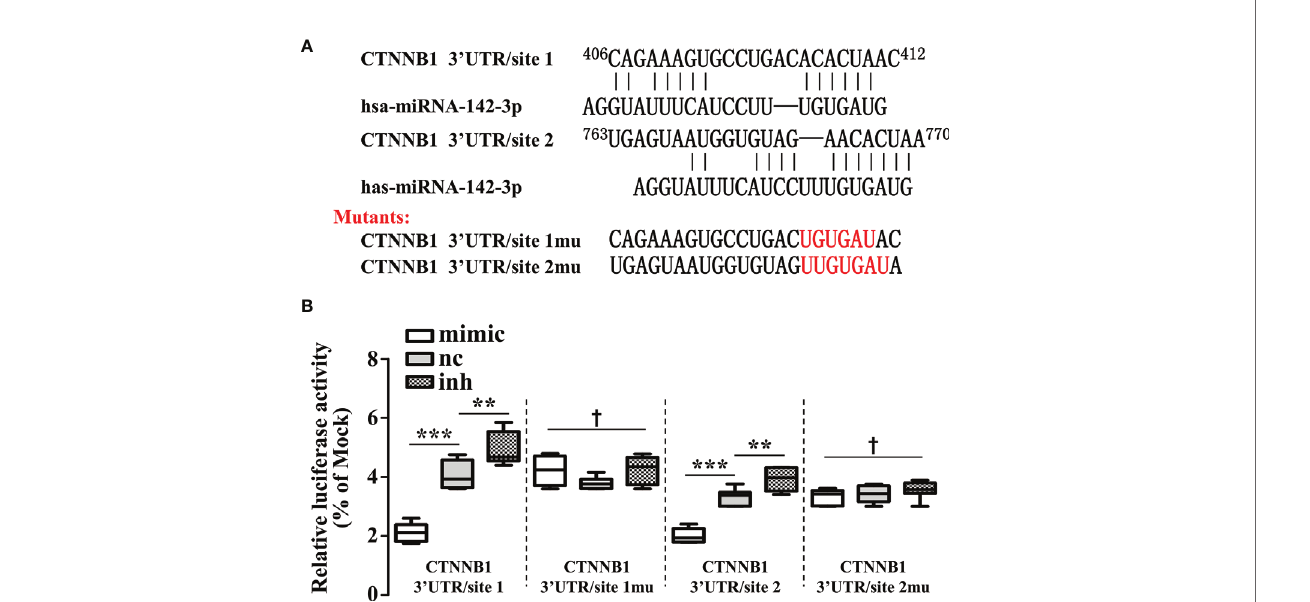
FIGURE 5 | b -catenin is a direct target of miRNA-142-3p. (A) The two predicted binding sites and the mutations that disrupt the associations between miRNA-142-3p onto the b -catenin (CTNNB1) mRNA 3 ′ -UTR. (B) The relative luciferase activity (FL/RL) was measured in HT29 cells after co-transfection of the b -catenin 3 ′ -UTR or b -catenin 3 ′ -UTR mutant luciferase constructs with either miRNA-142-3p mimics, NC, or inhibitors (100 nmol/L). All data are shown as means ± SD. *** represents signi fi cant difference with p < 0.001, while † represents p > 0.05. ** represents signi fi cant difference with p <